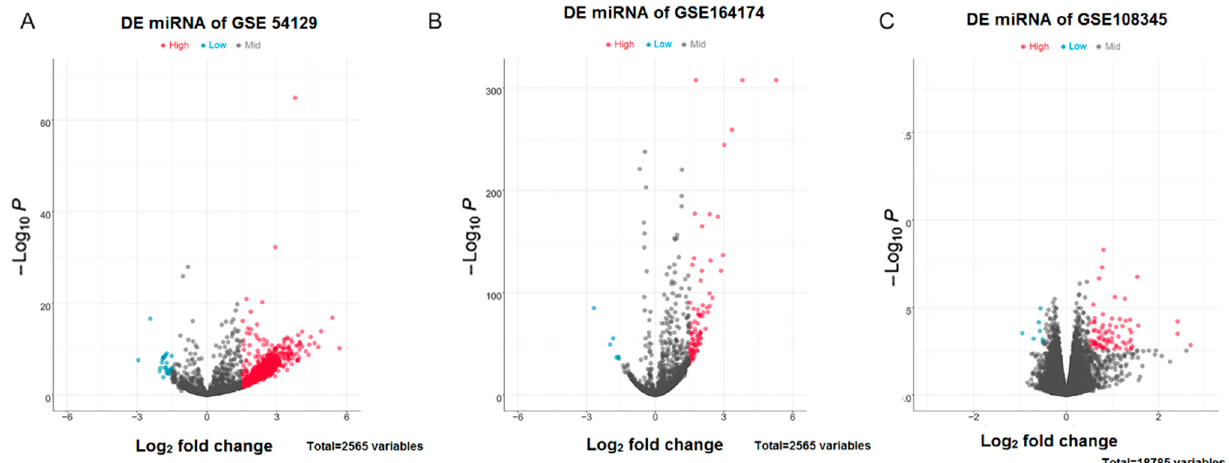
Figure 1. Volcano plots for DEmiRNAs. ( A ) DEmiRNAs in the GSE54129 dataset; ( B ) DEmiRNAs in the GSE164174 dataset; ( C ) DEmiRNAs in the GSE108345 dataset. The horizontal coordinates indicate log2FoldChange, while vertical coordinates indicate the − log10P-value. Blue color indicates significantly downregulated DEmiRNAs, whereas red color indicates significantly upregulated DEmiRNAs.